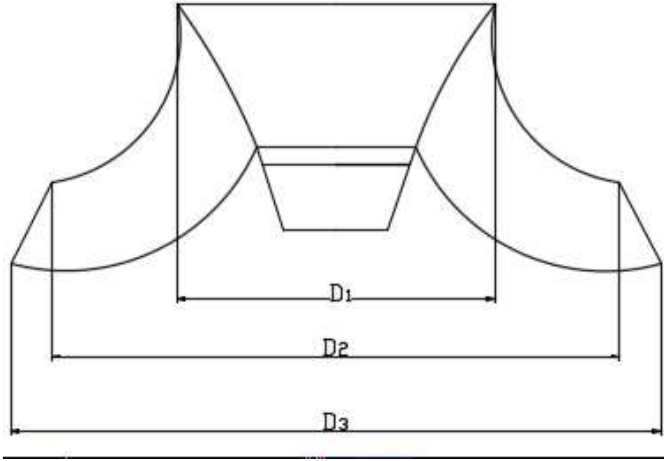
Figure 3. Cross section of a Francis runner.